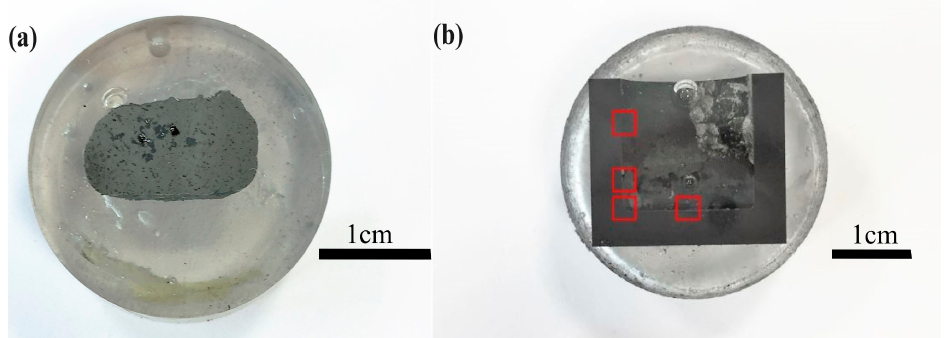
Figure 8. Graphite crucible and Fe-Si-B sample after being mounted, ground, and polished. ( a ) the Fe-26.38Si-9.35B alloy after thermal cycle experiment, ( b ) the graphite crucible after thermal cycle experiment, the red rectangles represent the positions that are analyzed by optical microscopy.